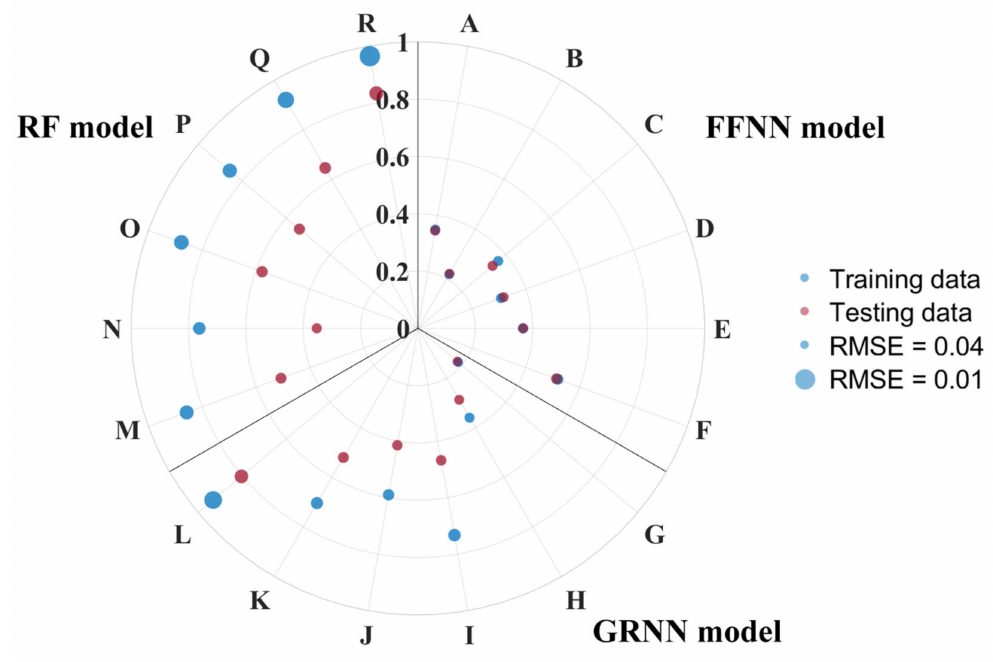
Figure 9. Training results of pH inversion models for 18 groups of experiments. A–F are from the FFNN model, G–L are from the GRNN model, and M–R are from the RF model. The two-colored points with the same polar angle correspond to the same set of experiments, with the blue points representing the results of the training set and the red points representing those of the testing set. The polar diameter of the dots represents the size of R 2 ; the closer to the origin the dots are, the smaller R 2 is, and vice versa. The radius of the dot is taken as the reciprocal of the RMSE (i.e., 1/RMSE), and the smaller the RMSE, the larger the radius of the dot. The sizes of the dots with RMSE = 0.01 and 0.04 are also given in the figure for reference.